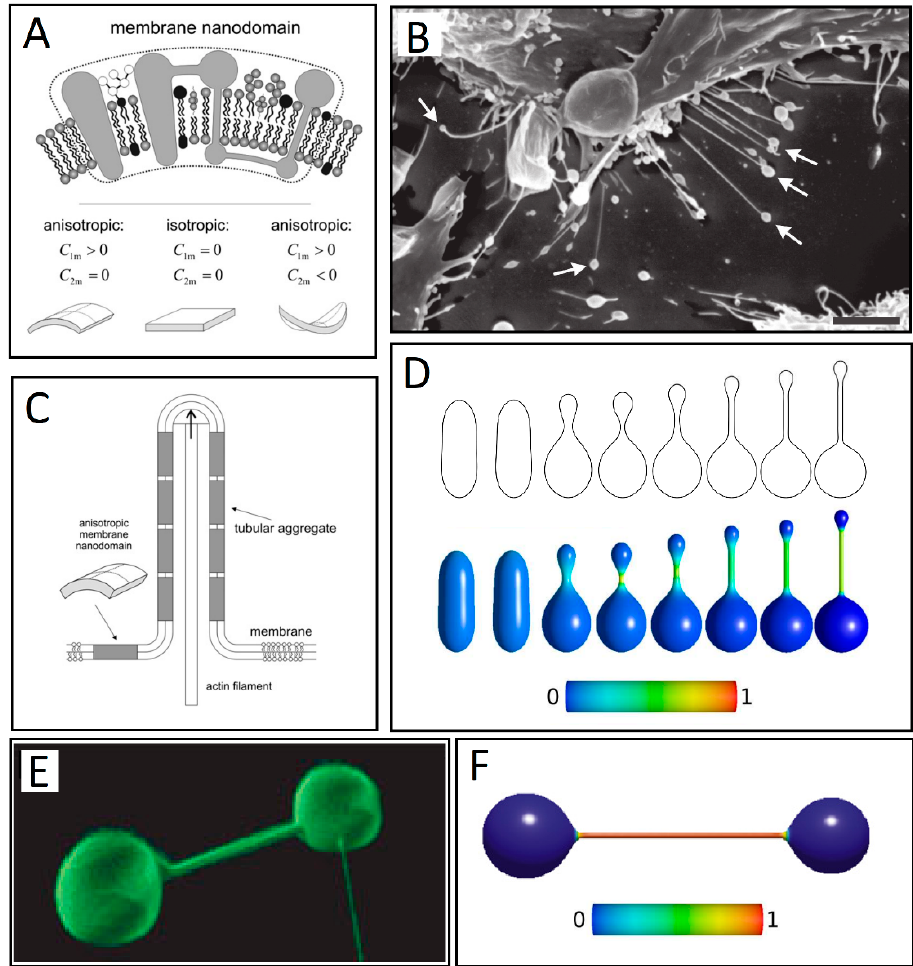
Figure 4. ( A ) Schematic figure of three different kinds of intrinsic shapes of flexible membrane nanodomains: partly cylindrical, flat, and saddle-like. Nanodomains with C 1m > 0 and C 2m < 0